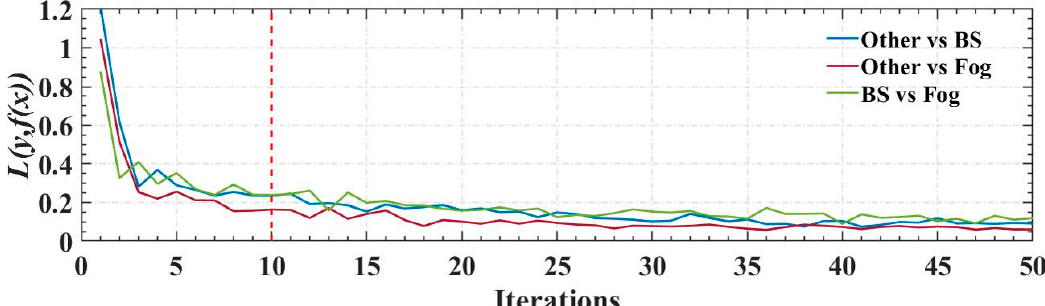
Figure 3. The variation trend of loss value with the increase of iterations of other situations (Other) vs. blowing snow (BS), other situations vs. fog and blowing snow vs. fog in the training set. 6.